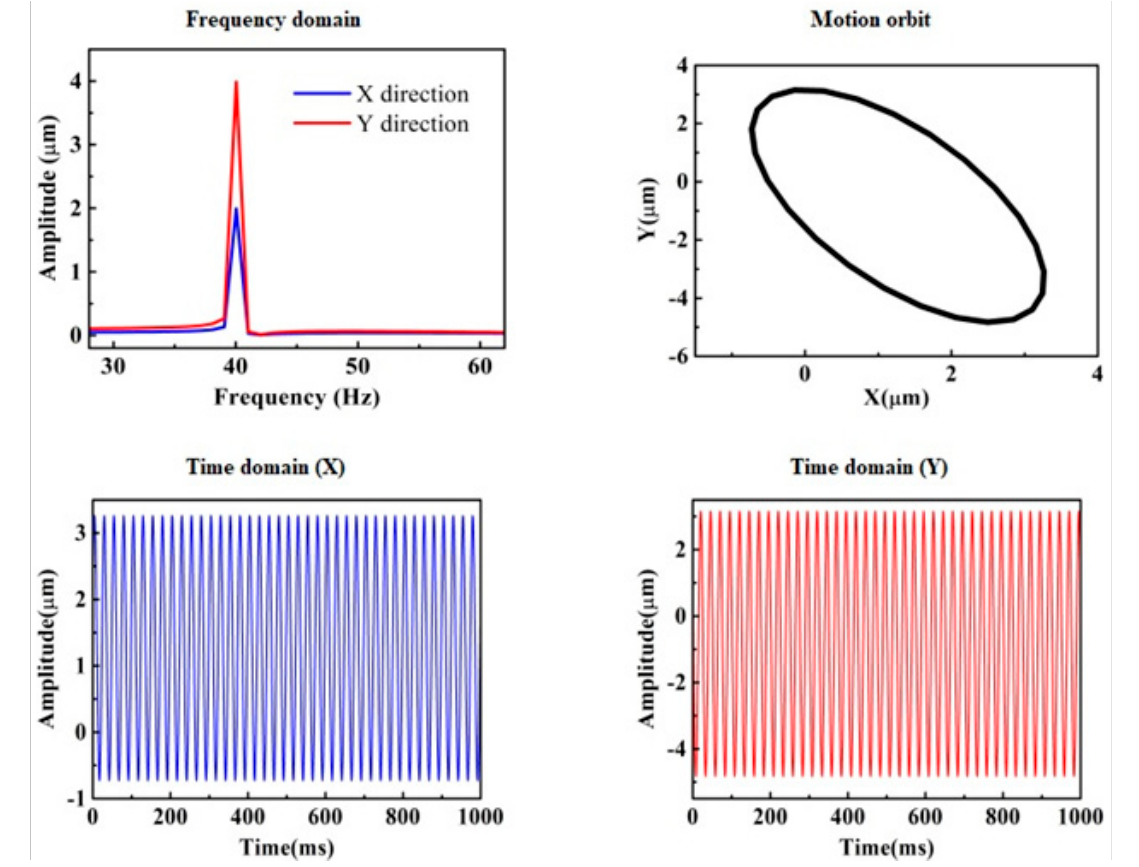
Figure 12. A data ‐ processing software programmed by the authors. Figure 12. A data-processing software programmed by the authors.